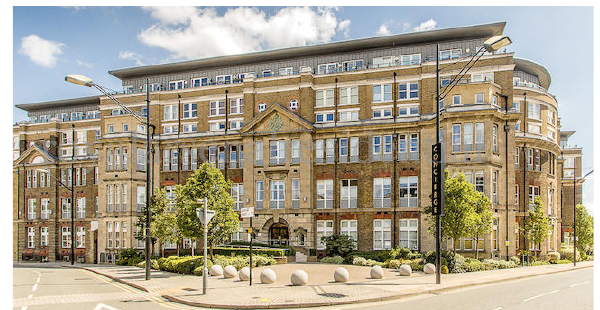
Figure 3: Building 22 after